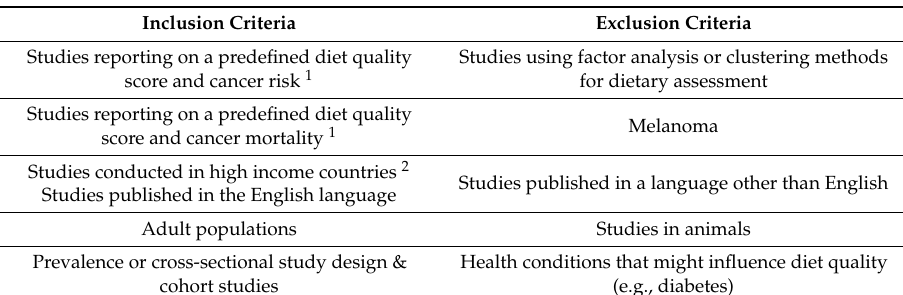
Table 1. Inclusion and exclusion eligibility